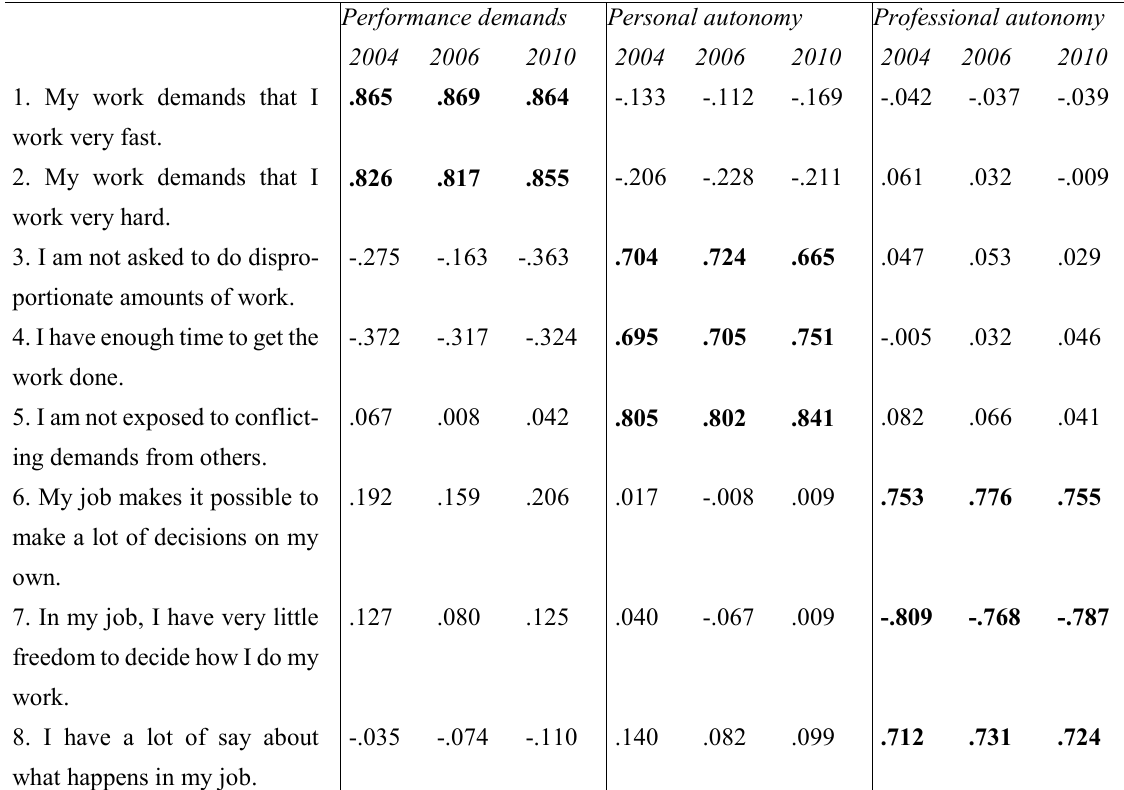
Merged variables’ Rotated Component Matrix Performance